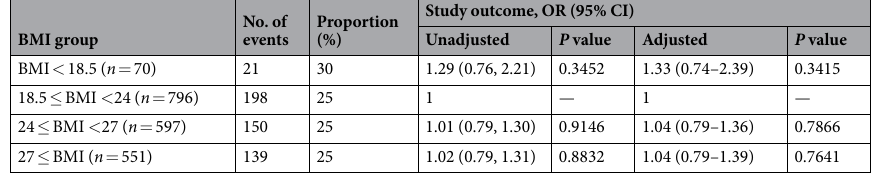
Table 6. Association between BMI and the risk of eGFR progression among patients with CKD stages 3b–5. Models were adjusted for age, sex, DM, CAD, Stroke, cancer, hypertension, Charlson score, TB, COPD, ACEI, ARB, fibrate, smoking, alcohol consumption, betel nut chewing, UPCR and eGFR. OR, odds ratio; CI, confidence interval; BMI, body mass index; DM, diabetes mellitus; CAD, coronary artery disease; CKD; chronic